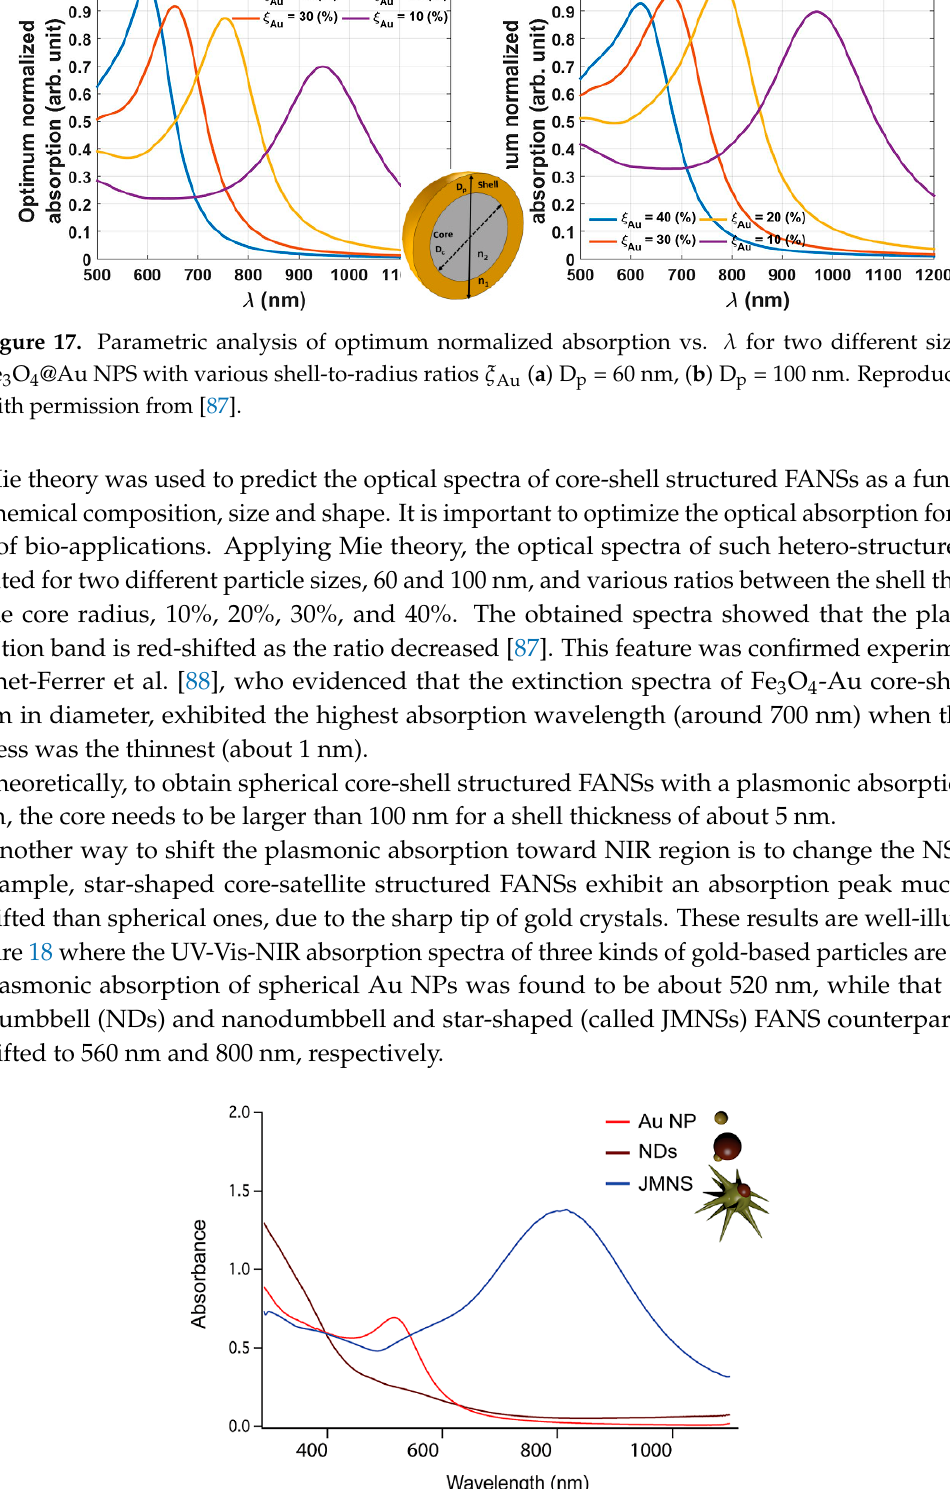
Figure 18. UV-Vis spectra comparing the absorbance of spherical Au NPs (in red), nanodumbbells (in brown) and nanodumbbell and star-shaped (in blue) FANS counterparts. Reproduced with permission from [22]. Royal Society of Chemistry, 2016.